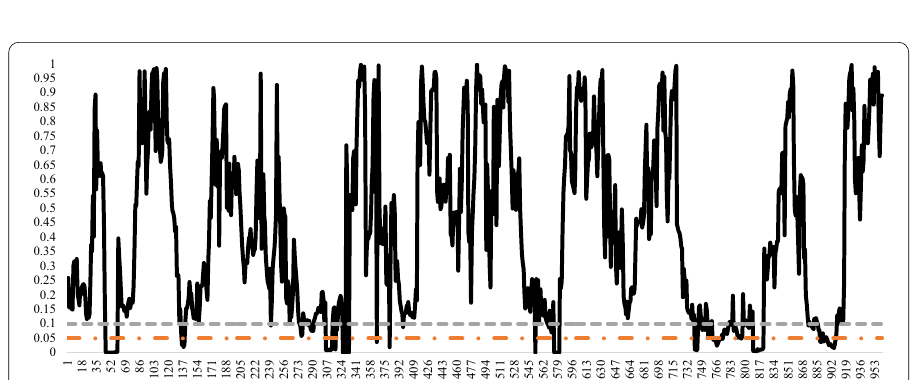
Fig. 14 The evolving p values of the AQ test statistic checked for the Gold in 50-day window